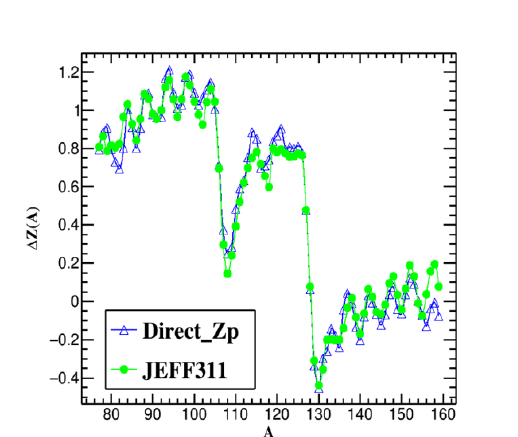
Fig. 11. Empirical calculation of post-neutron charge polarization from the JEFF-3.1.1 data (green) compared to the same calculation from charge distribution using the direct-Zp model (blue) .